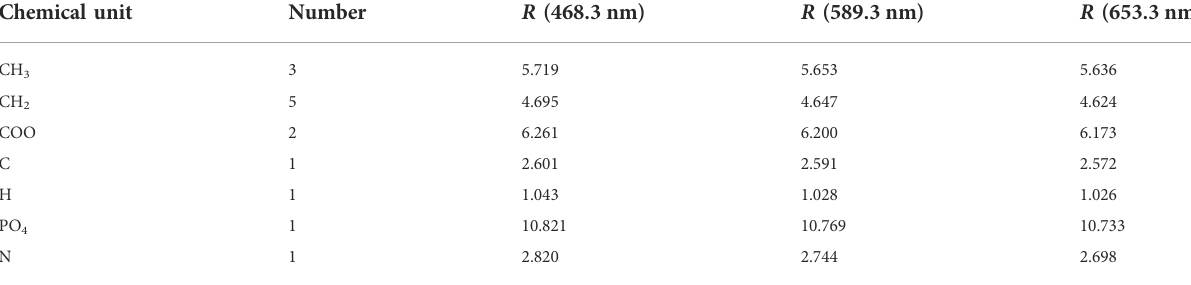
TABLE 1 Chemical units used for the hydrophilic head of a DMPC